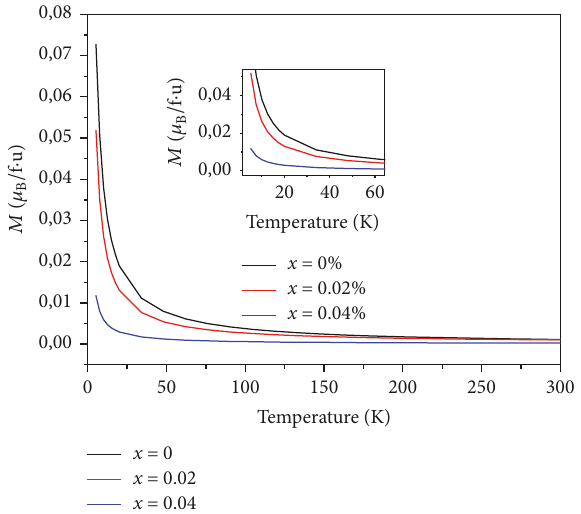
Eu (PO 3 ) 4 (x=0, x - x )